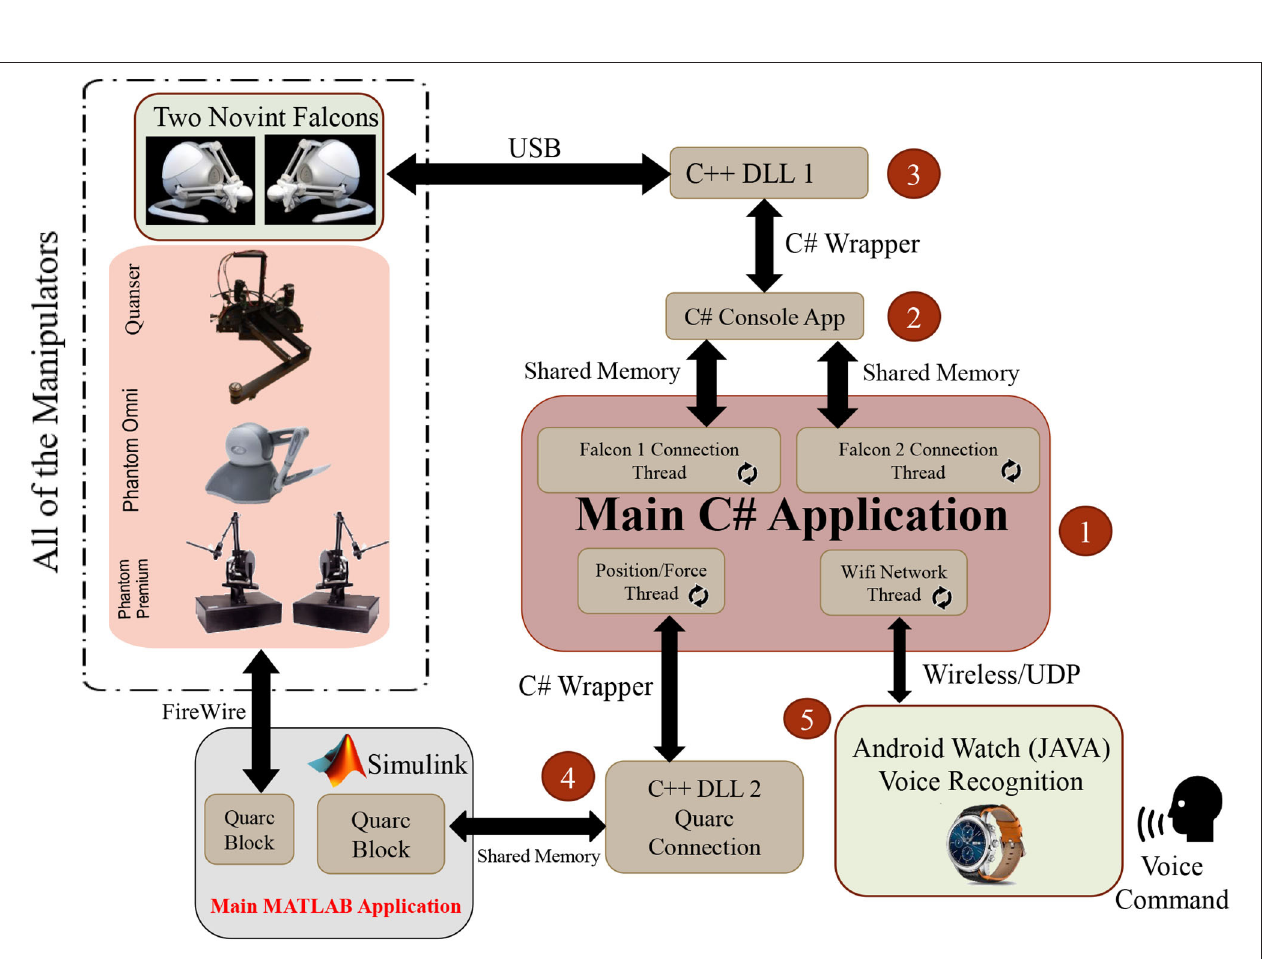
FIGURE A2 | Overview of the implemented software for the proposed method. As it is seen, the manipulators are selected in a non-homogeneous manner. That is, a dual set of Novint Falcon ® , one Phantom Omni ® , Two Phantom Premium ® robots, and one Quanser ® robot are provided for this purpose (R1–R6 in Figure A1 ). The software written for this system consists of five parts, all of which have been prepared and implemented by the authors of this article. Bilateral arrows represent the two-way communication between the marked blocks. For example, Novint Falcon robots send/receive data to/from the main system through the USB protocol and via the intermediate programs “C++ DLL 1” (Block #3) and “C# Console App” (Block #2). Block #3 and Block #2 are connected to each other via C# wrapper, and Block #2 is connected to the Block #1 via the shared memory. All the other blocks are connected to the robots in similar situation as shown in this figure.